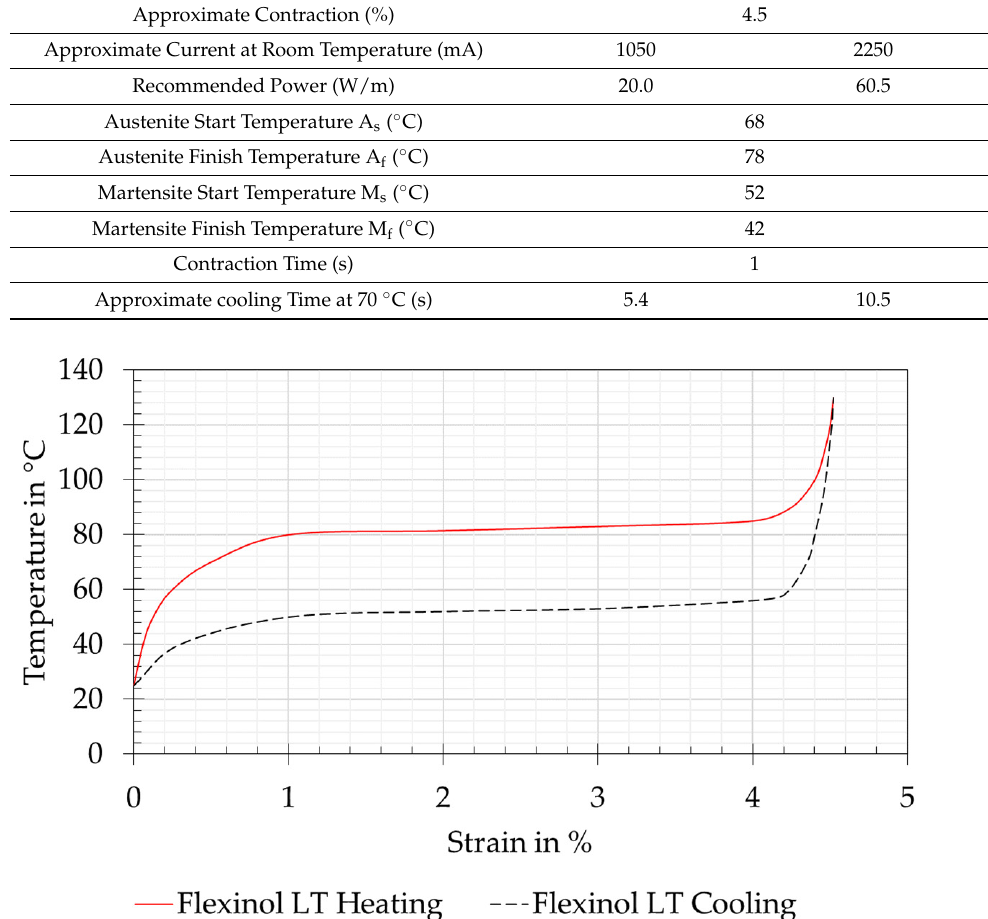
Figure 4. Relationship of the temperature to the strain of Dynalloy Flexinol Low Temperature (LT) wire during heating and cooling. Reproduced from [14].